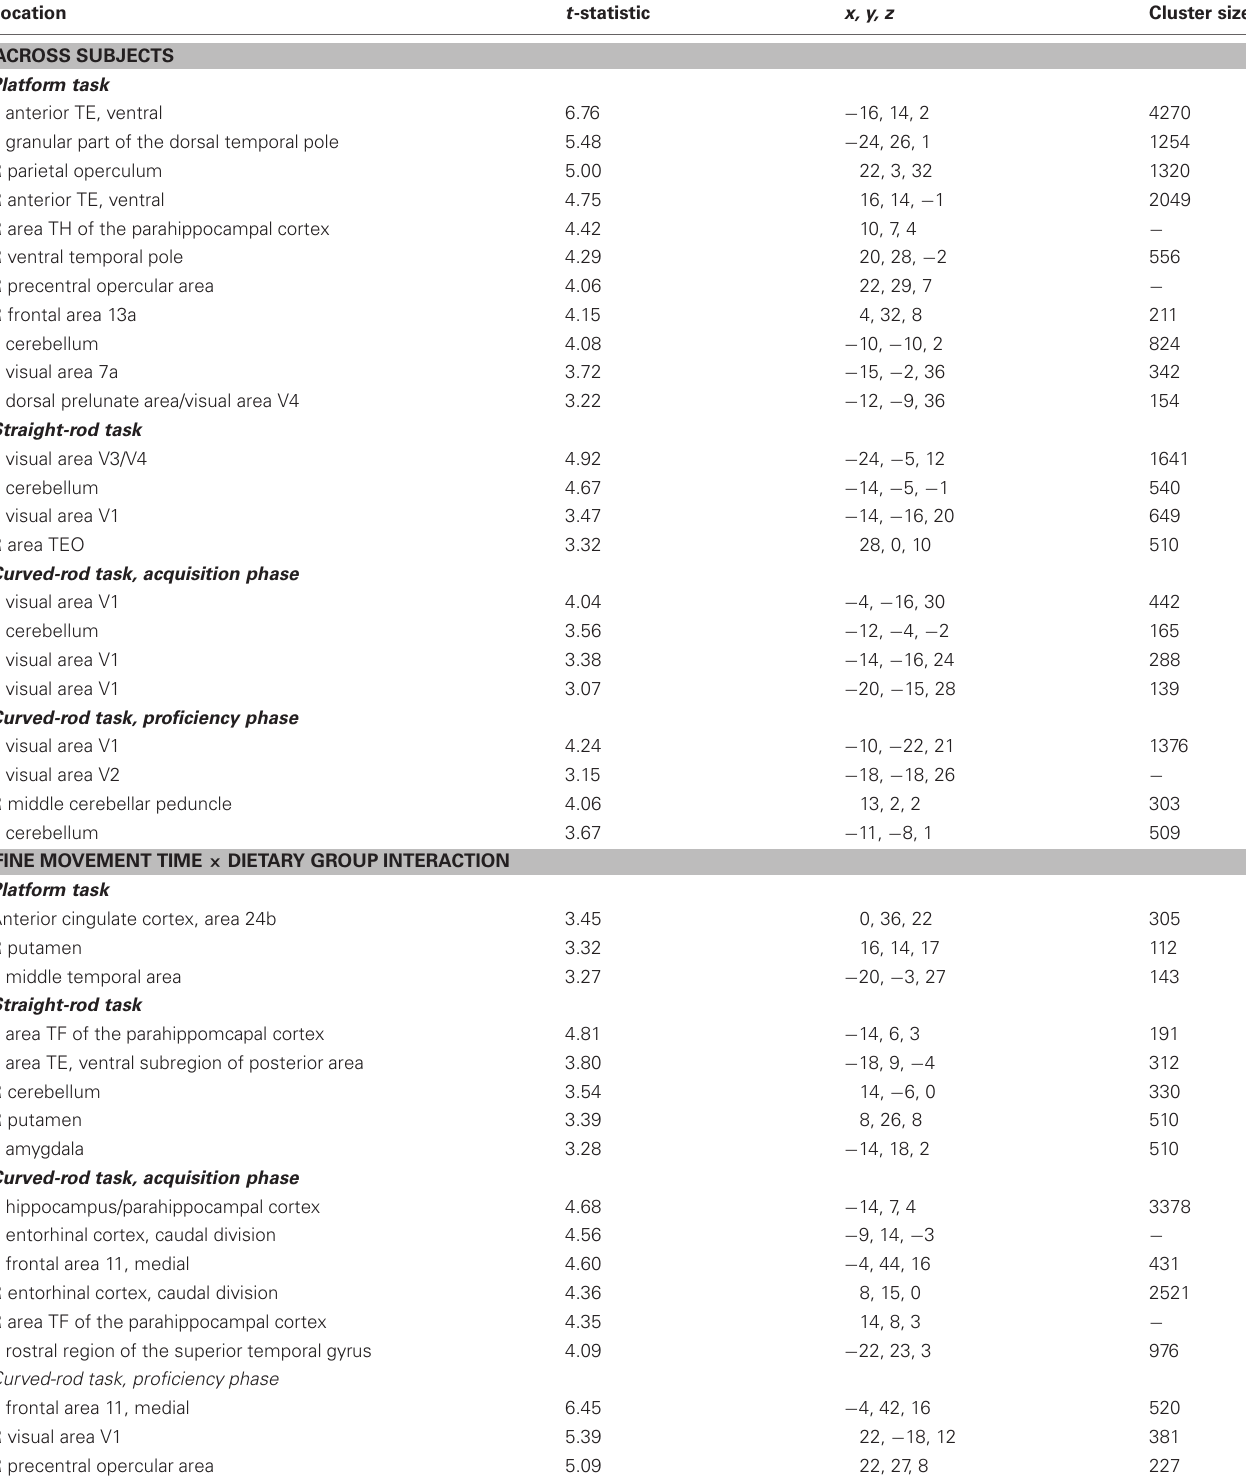
Table A3 | Regions where fine movement time was significantly correlated with gray matter volume in voxel-wise analyses across subjects and between dietary